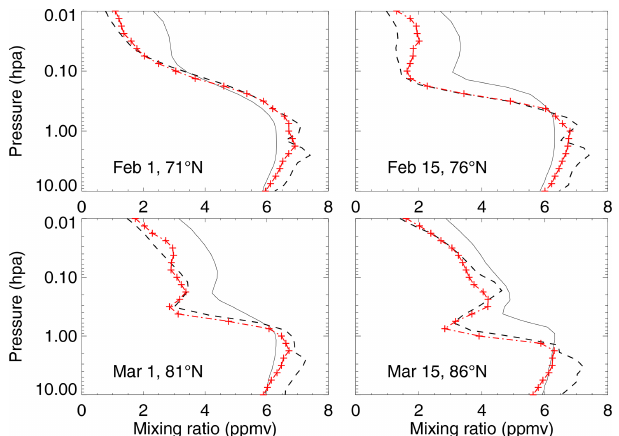
Figure 2. The pressure level of the nitric oxide 50ppbv value (bot- tom side of the layer). The pluses connected by a red line are daily values of the WACCMX results shown in Fig. 1. The black stars are the SOFIE data from Fig. 1.